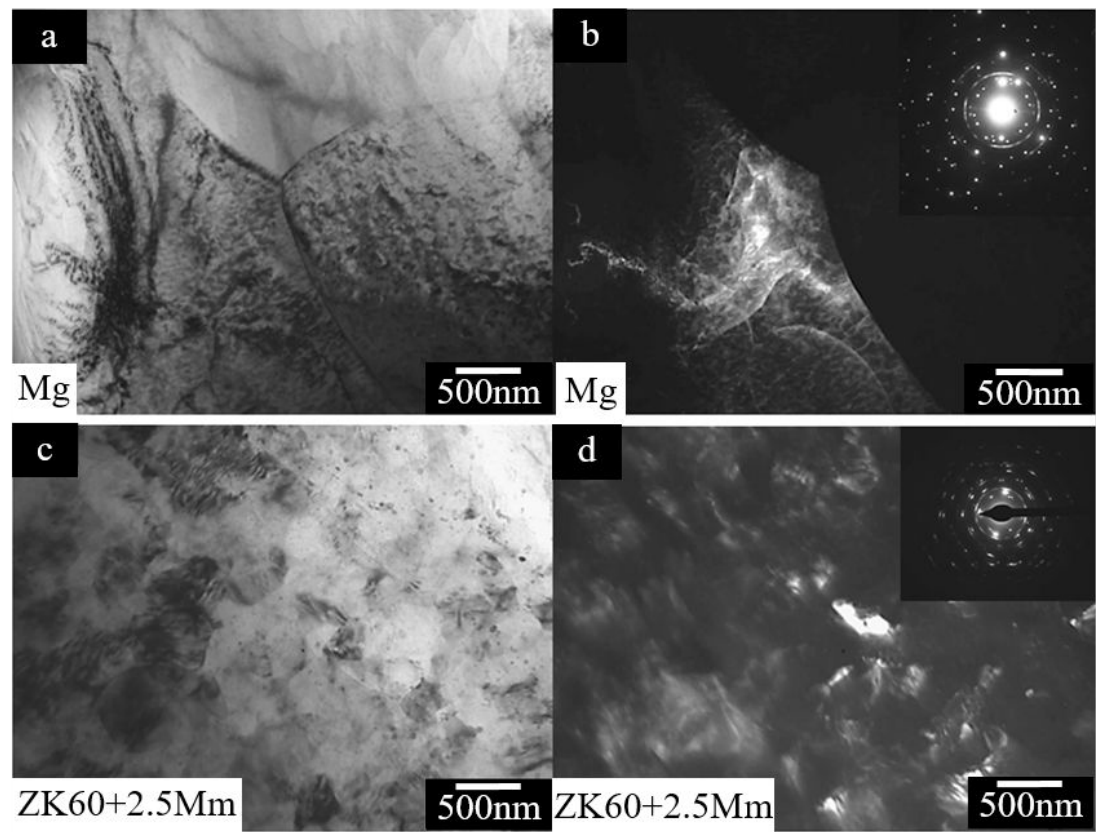
Figure 5. TEM images in BF (Figure 5a-c) and DF (Figure 5b-d) mode of pure Mg and ZK60+2.5Mm alloy after ECAP+LTR processing route. Table 2. Curve fitting parameters from XPS spectra of the Mg-2p peak. Samples after ECAP+LTR